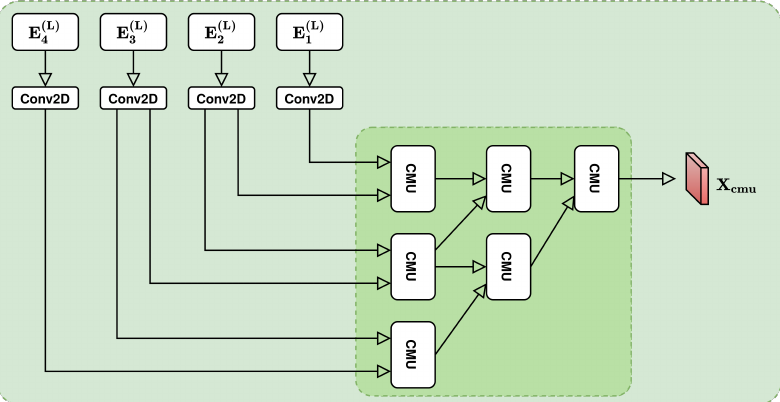
Figure 4. Cascading Hierarchical Block.